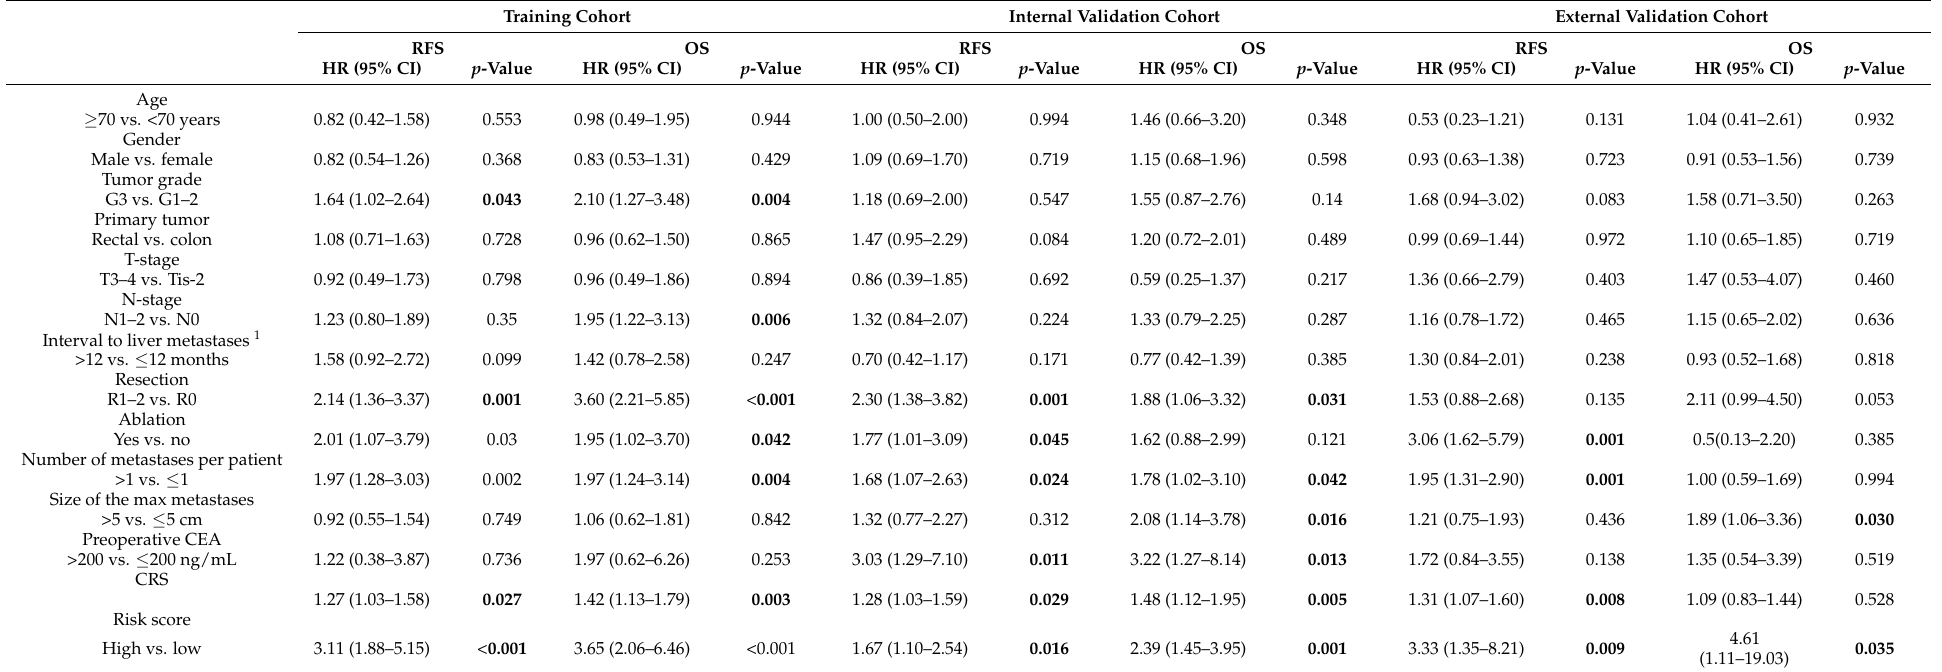
CEA, carcinoembryonic antigen. CRS, clinical risk score. Bold indicates p < 0.05. 1 Interval from primary tumor resection to liver